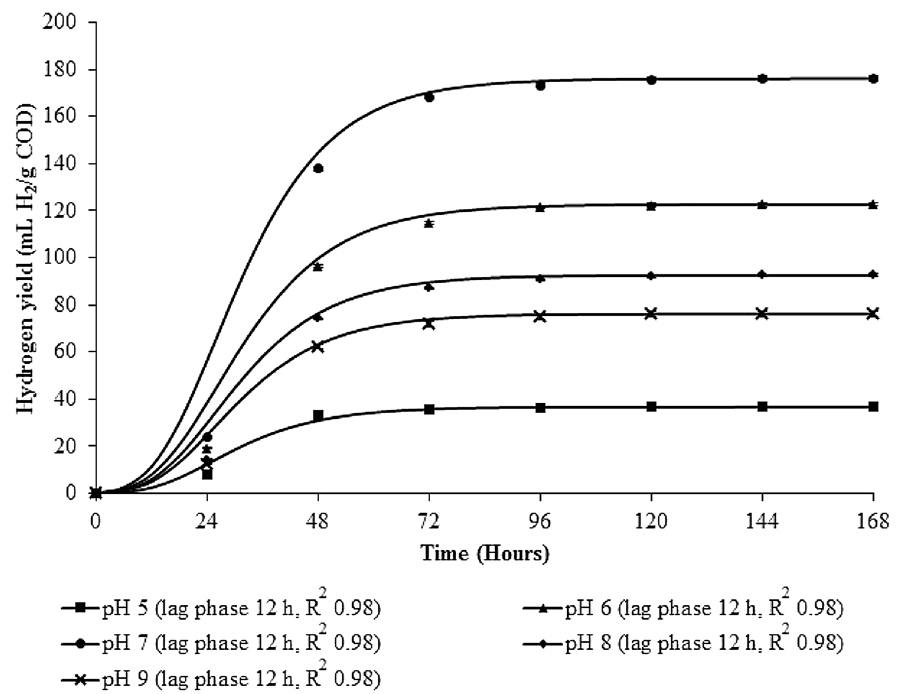
Fig. 1 Effect of initial pH on thermophilic biohydrogen